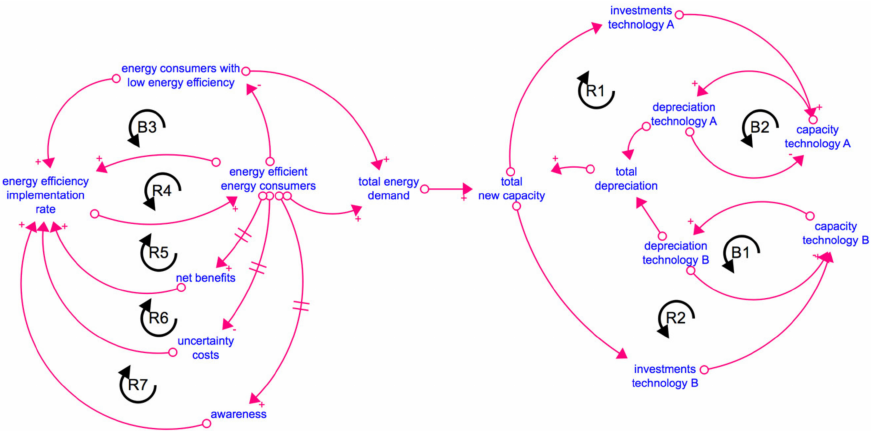
Figure 1. Broad causal loop diagram for the energy system. (R- reinforcing loops; B-balancing loops; ‘+’ is positive feedback link; ‘-‘ is negative feedback